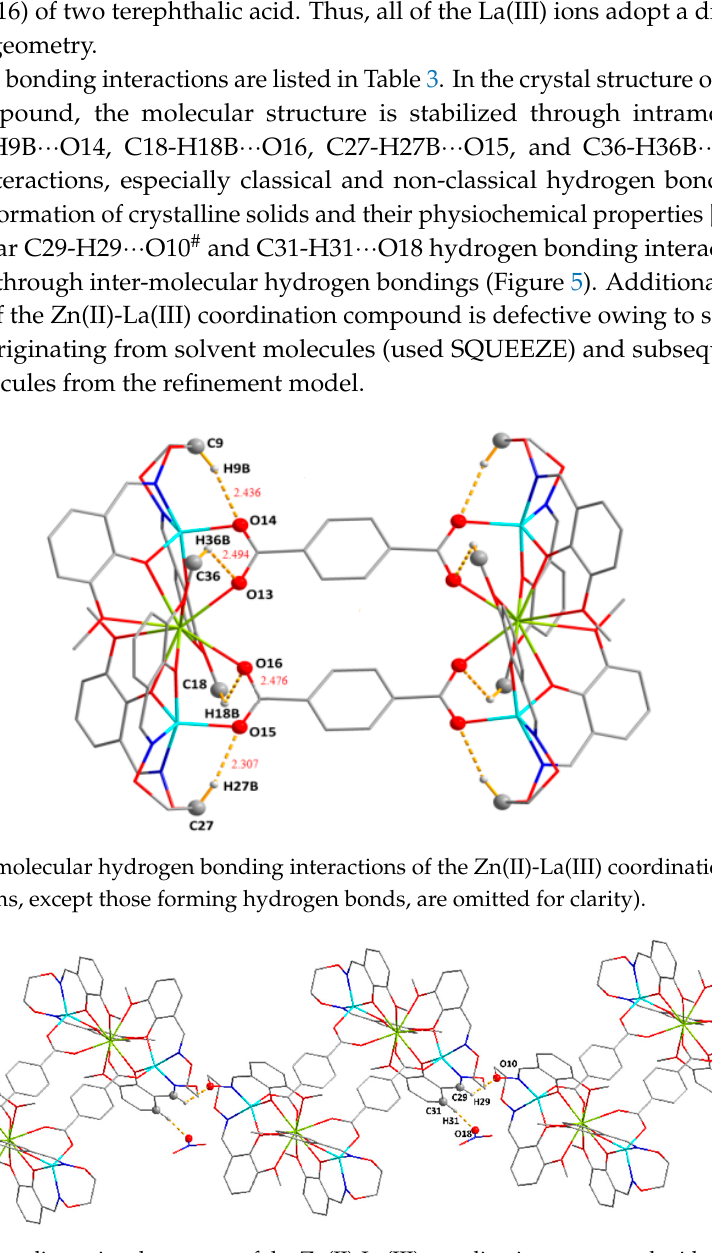
Figure 5. The one-dimensional structure of the Zn(II)-La(III) coordination compound with intermolecular hydrogen bondings (hydrogen atoms have been omitted except those formation of hydrogen bonds). Table 3. Putative hydrogen bonding interactions (Å, °) for the Zn(II)-La(III) coordination compound.